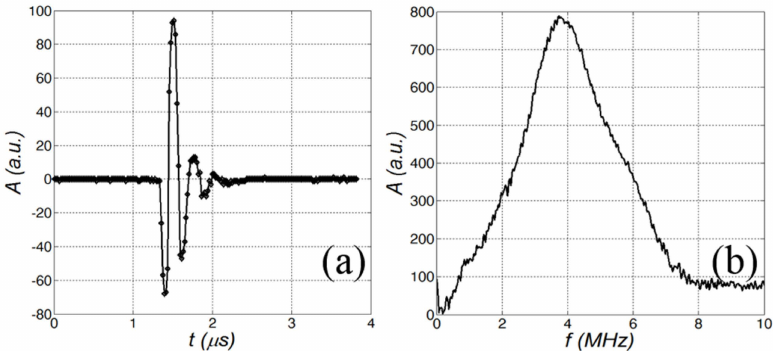
Figure 3. Excitation signal of a 5-MHz broadband transducer: temporal ( a ) and frequency ( b ) domain. The spectral content clearly reveals a central frequency around 4 MHz, instead of 5 MHz.